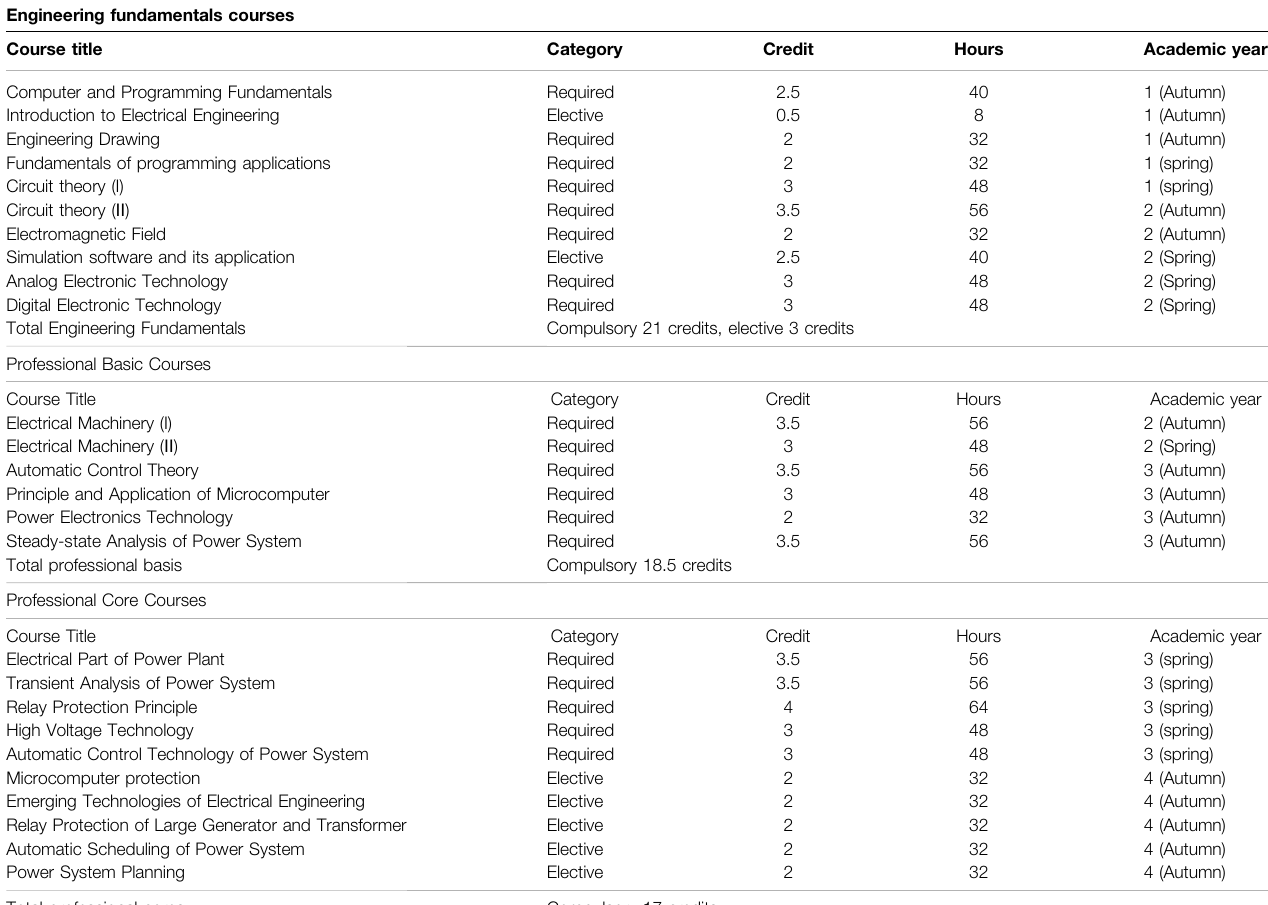
TABLE 2 | Curriculum Setting of Engineering basic courses, professional basic courses and professional core